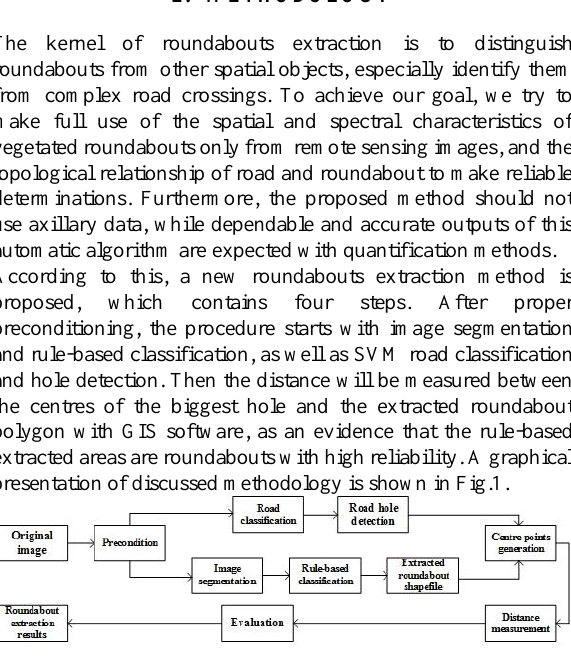
Figure 1. Flow chart of